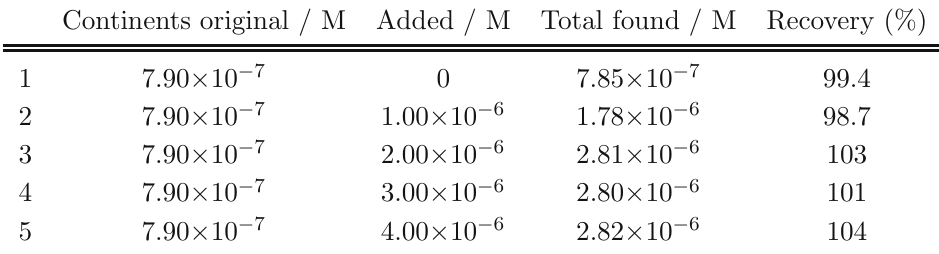
Table 2 Determination of sulfaniliamide concentatration in sample